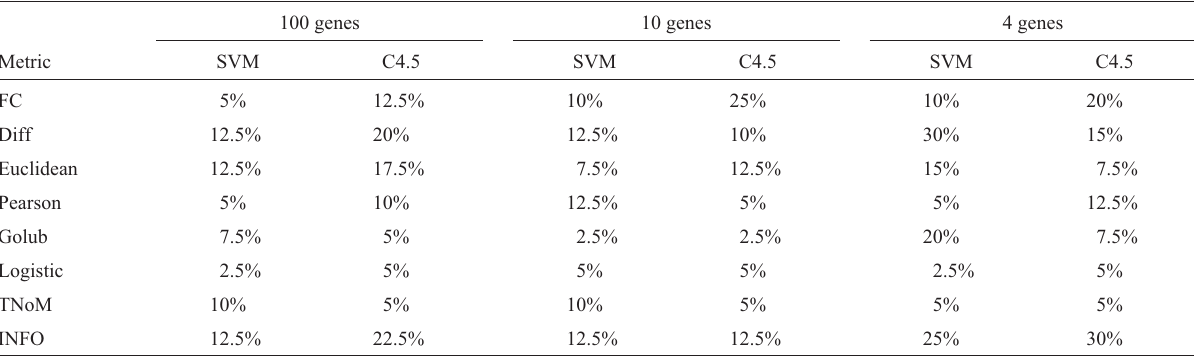
Table 3 - Summary of the